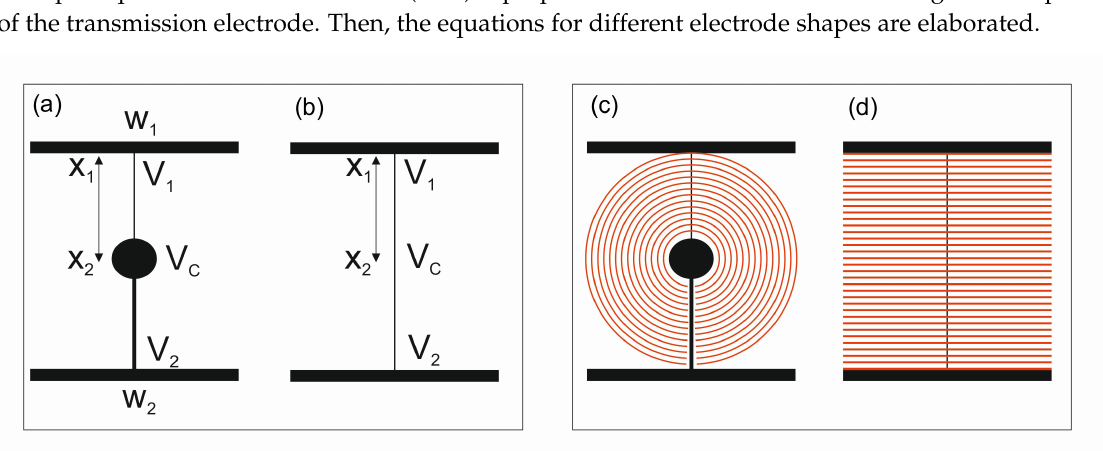
Figure 1. Schematic diagram of the transmission electrode technique. Detail of the transmission electrode (in black) for ( a ) voltage divider configuration and ( b ) orthogonal configuration. Detail of the ( c ) concentric and ( d ) parallel electrodes stubs (in red) that distribute the voltage over the active area. Note in ( c ) that the stubs do not touch the bottom part of the transmission